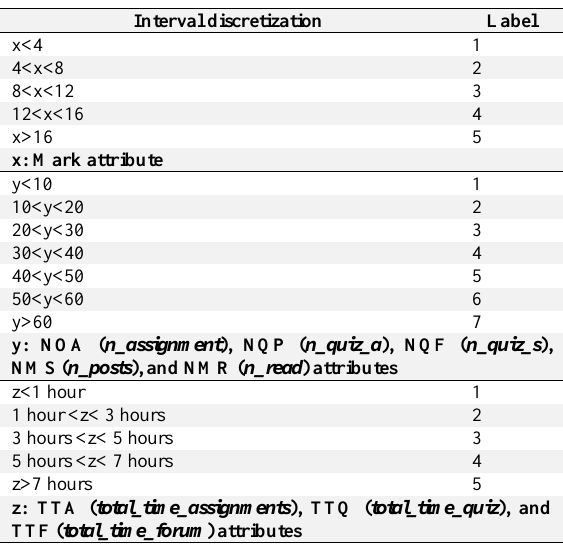
Table 5. Attributes interval